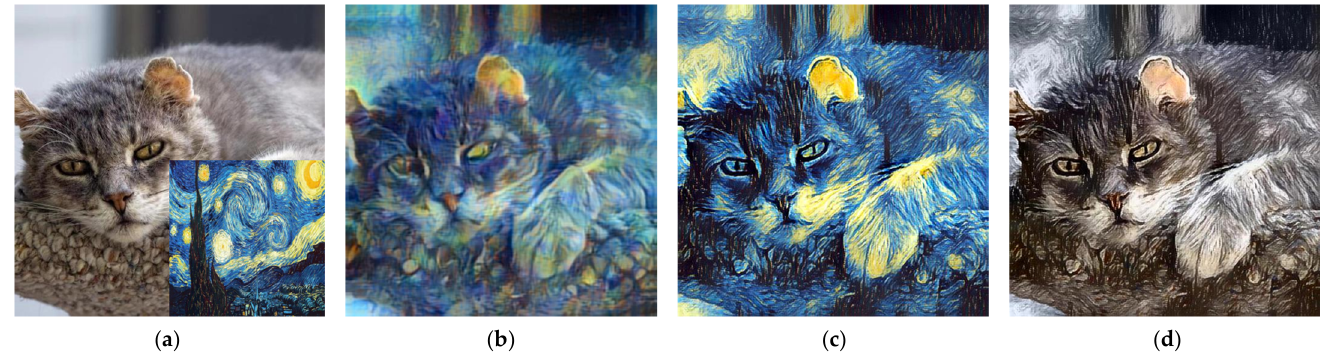
Figure 2. Different stylization results from the same content image and style image: ( a ) the content image is a cat, and the style image is Starry Night by Vincent van Gogh; ( b ) this stylized image is generated directly by our coarse network in the first stage; ( c ) the final stylized image is generated by our full model in the second stage; ( d ) this stylized image maintains the same color as the content image using color control.